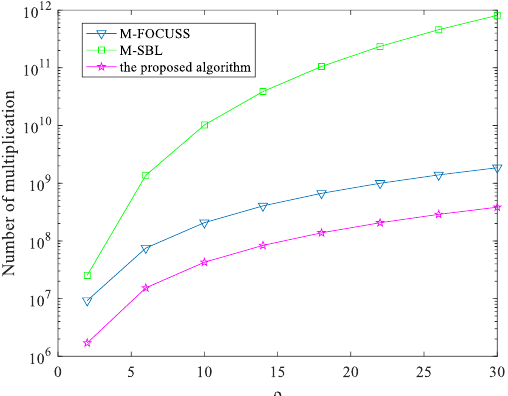
Figure 1. Computational complexity versus for a single iteration.